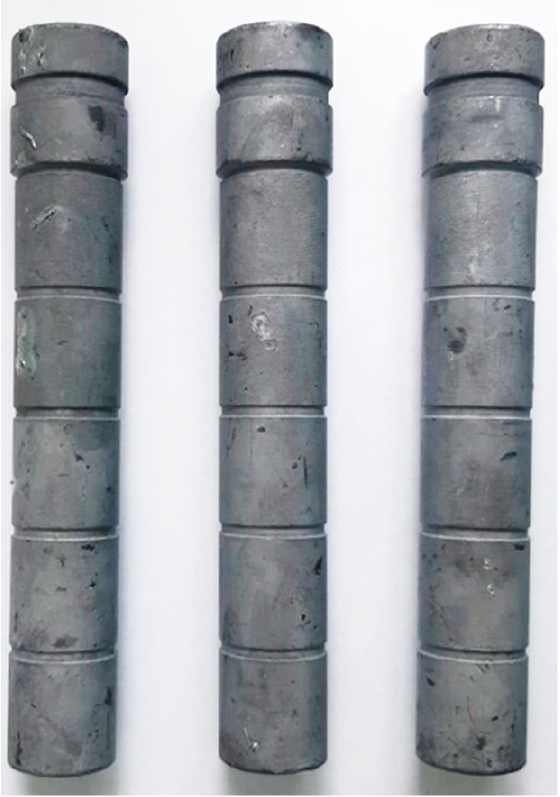
Figure 2. Hot dip galvanized parts with centrifugation.